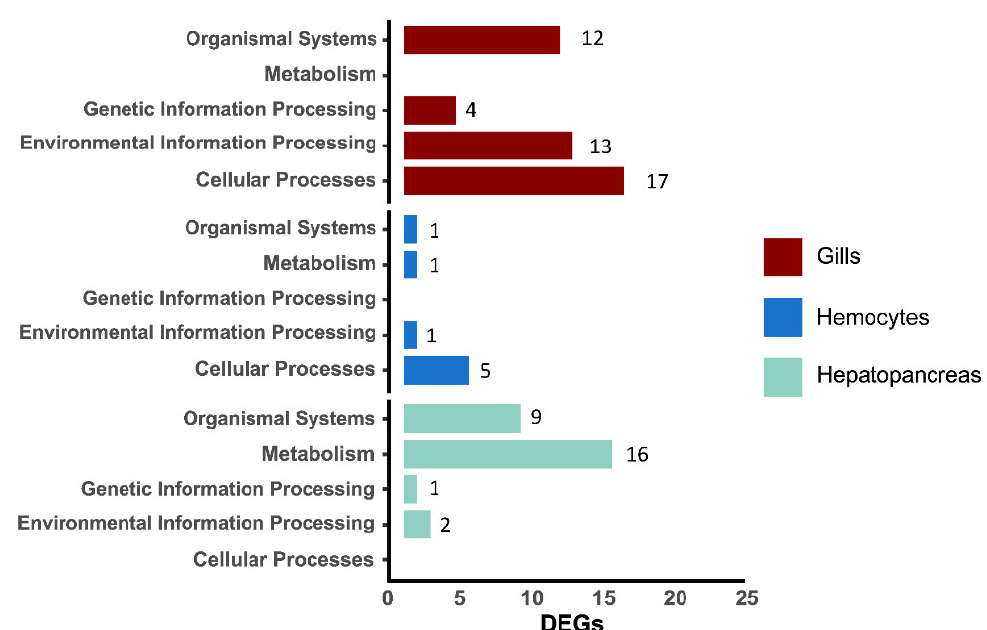
Figure 1. Histogram of the number of DEGs in the gills, hemolymph, and hepatopancreas of P. vannamei under three pathogens infection assigned to five KEGG level 1 categories, i.e., organismal systems, metabolism, genetic information processing, environmental information processing, and cellular processes.